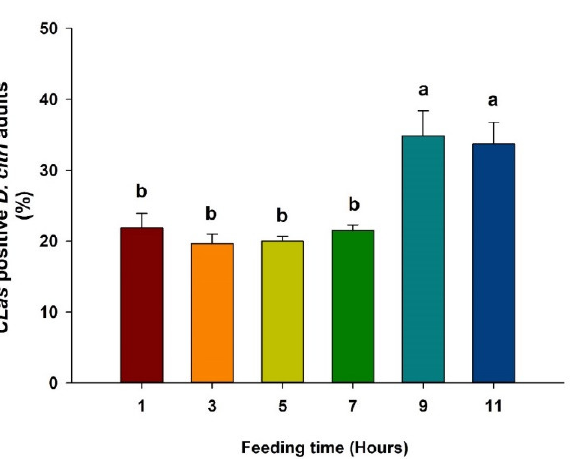
Figure 3. Percentage of C Las-positive D. citri adults feeding on C Las-infected citrus plants for different time durations. The bars display the average from three replications. The standard deviation of the mean is shown by the standard error bars. The significance of the treatments at p < 0.05 is shown in lowercase lettering. Similar letters represent no significant difference among the treatments.